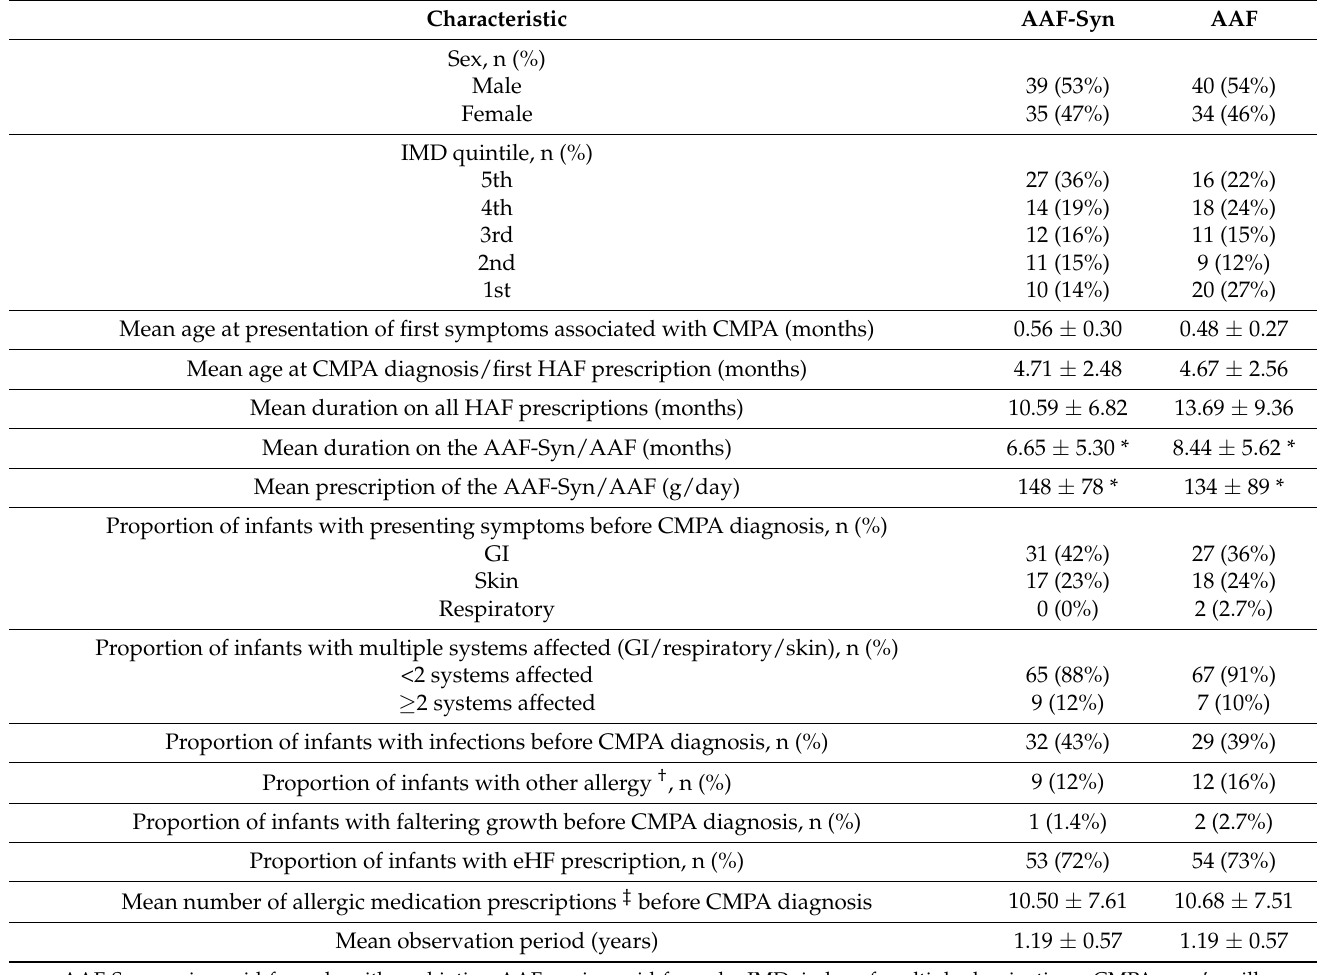
Table 2. Infants’ baseline